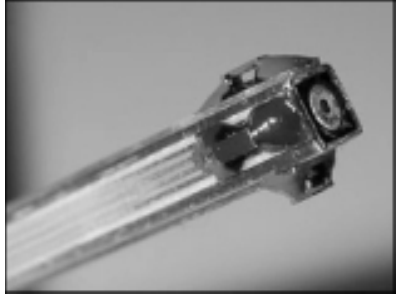
Fig. 1. Microflown USP probe.